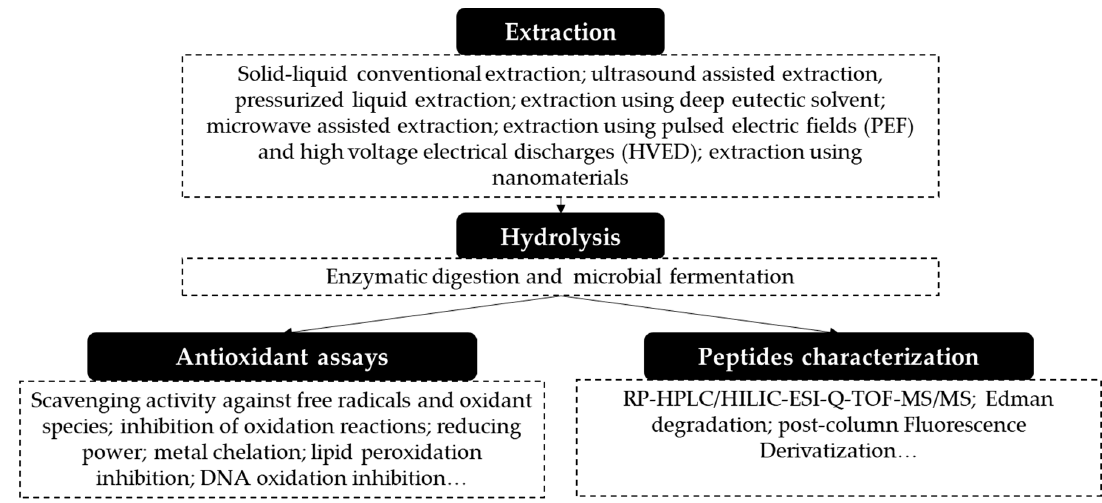
Figure 1. General procedure employed for obtaining proteins and peptides from fruit residues. Rp-HPLC: reversed-phase HPLC; HILIC: hydrophilic interaction chromatography; ESI: electrospray ionization; and Q-TOF: quadrupole time-of-flight.